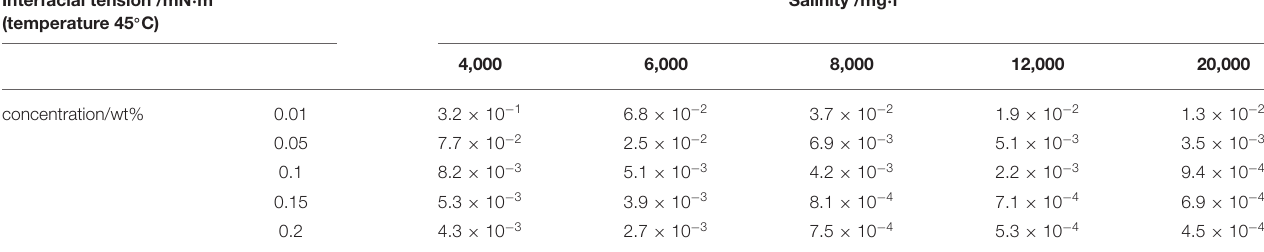
concentration/wt%